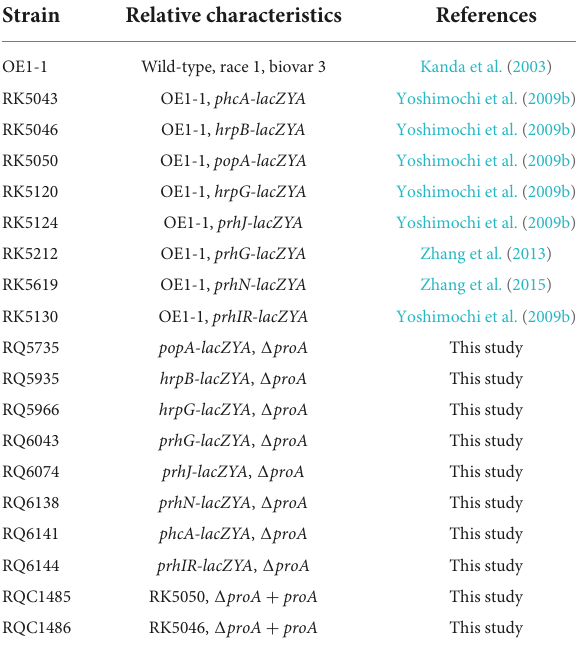
TABLE 1 Bacterial strains used in this